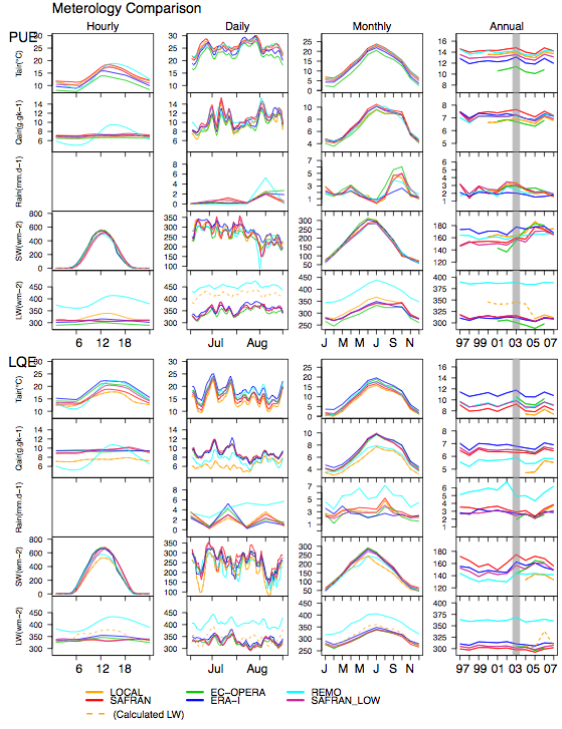
Fig. B1. Meteorological drivers in in situ and in gridded data sets at six sites. First column: hourly mean diurnal cycle over peak growing season (PGS). Second column: daily mean with a run- ning mean of 3 days for July–August of 2003 at HES, LBR and PUE and of 2005 for LQE, AVI and GRI. Rainfall is calulated as 5-day aggregated values; third column: monthy mean seasonal cy- cle; fourth column: annual mean. The hourly mean diurnal cycle and monthly mean seasonal cycle correspond to 2004–2007 except for EC-OPERA (2003 to 2006). In the case of site-year without mea- sured LW down , calculated LW down is plotted in dash lines.